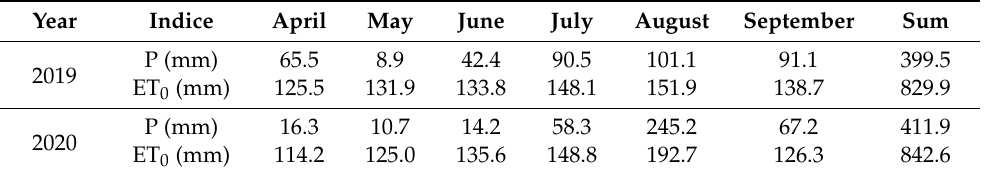
Table 2. Variation of monthly precipitation (P) and monthly reference evapotranspiration (ET 0 ) of